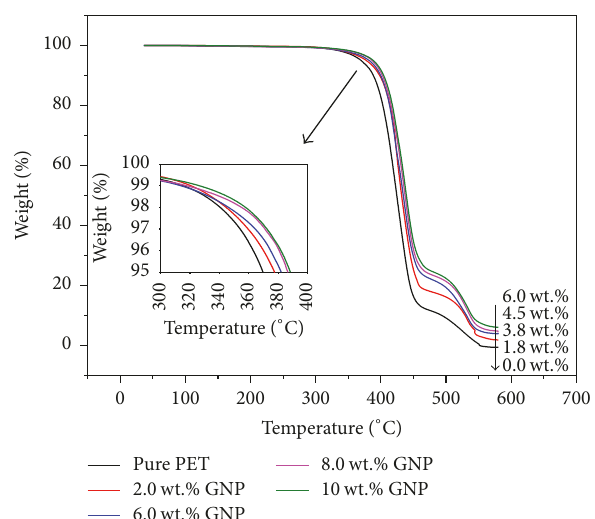
Figure 11: TGA thermograms of nanocomposites examined under air atmosphere.